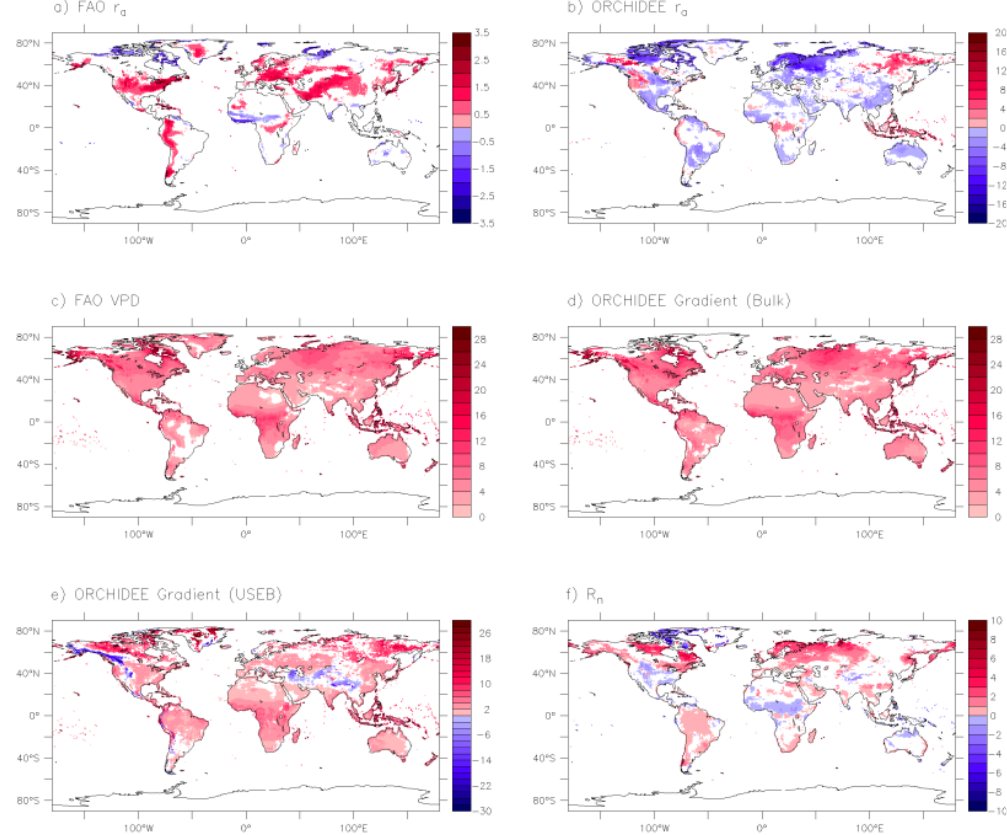
Fig. 2. Significant trends showing the increasing or decreasing % per decade for the aerodynamic resistance ( r a ), the VPD, the humidity gradient, and the net radiation ( R n ), regarding the IPSL A2 scenario and the different formulations. The blank areas correspond to regions where no significant trends have been